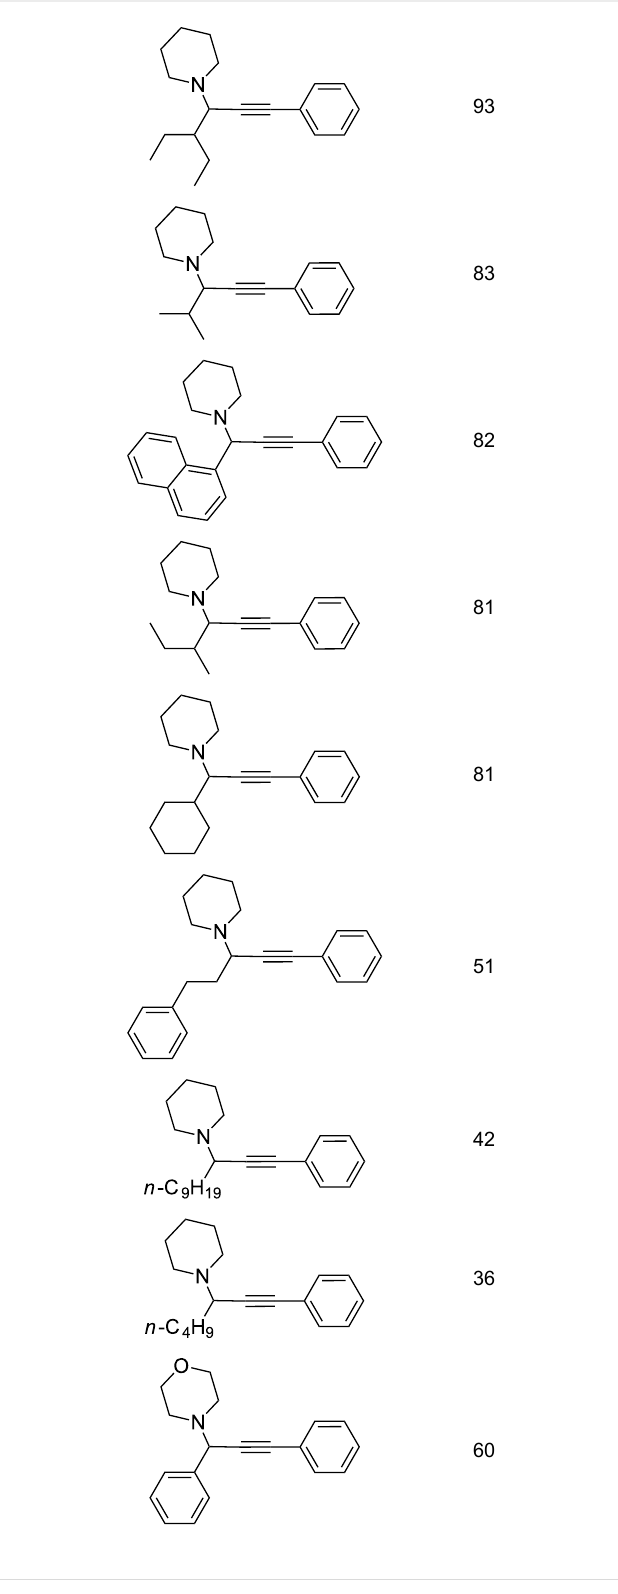
Table 2: Three-component coupling of aldehyde, amine, and phenylacetylene catalyzed by Au@SH-CNC catalysts in solvent-free conditions. a